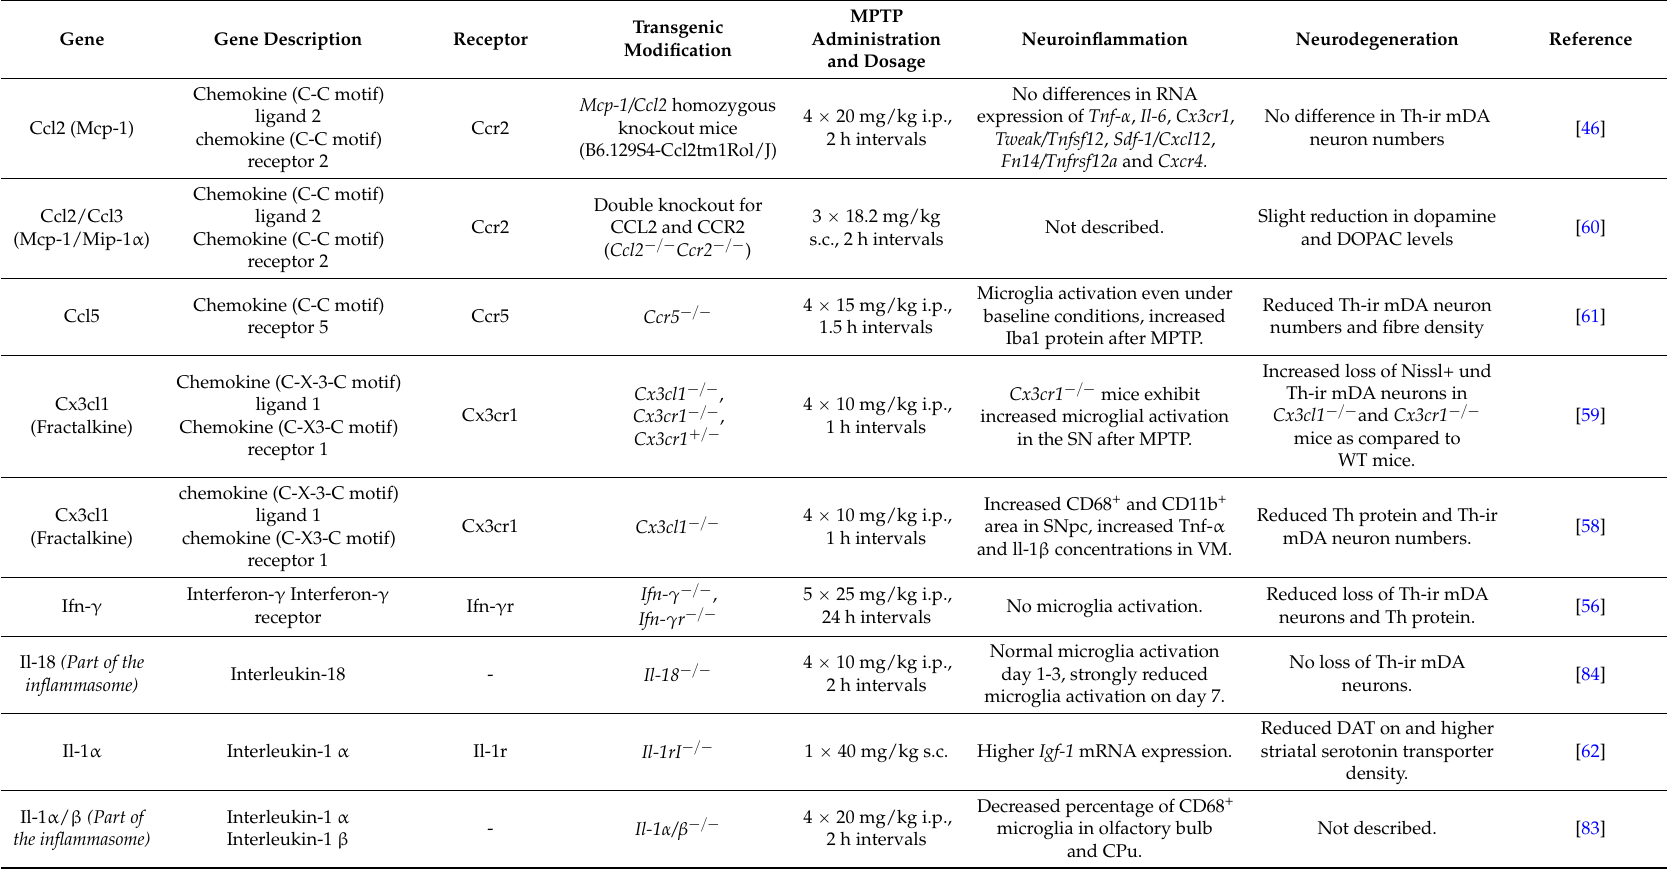
Table 1. Cytokine signalling and